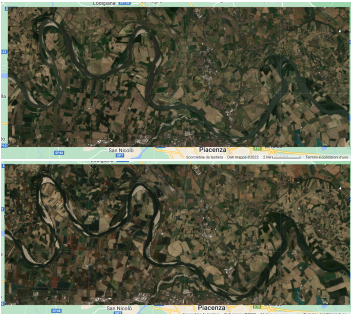
Figure 14. Sentinel-2 median image of Po river on April-June 2020 (above) and on April-June 2022 (below).